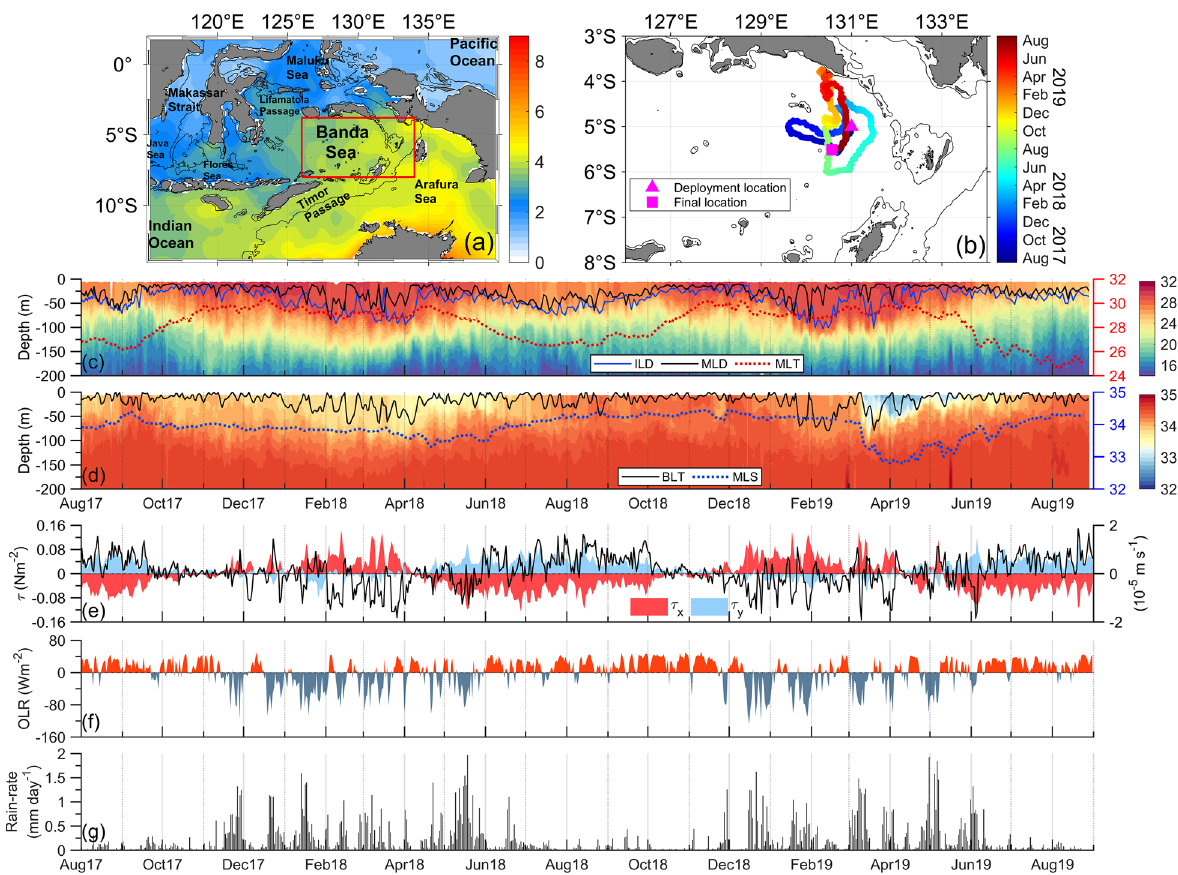
Fig. 1 a Map of the Indonesian Maritime Continent showing the amplitude of the seasonal cycle of SST (°C). b The trajectory of the Argo float (WMO ID 6901746) from August 2017 to August 2019. Solid black contours in a , b show the 500 m isobath. Time-depth sections of c daily temperature (°C) and d daily salinity (psu) along the trajectory of the Argo float 6901746. e Temporal evolution of daily zonal and meridional wind stress (N m − 2 ). f Daily OLR anomaly (W m − 2 ), and g daily precipitation (mm day − 1 ). The area boxed by red lines indicates the location of the area captured in b . The blue and black lines in c denote the ILD and MLD, respectively. The black line in d denotes the BLT. The dotted red and blue lines in c and d indicate the MLT ( o C) and MLS (psu), respectively. The black line in e denotes the vertical velocities (m s − 1 ) associated with Ekman pumping. All plots in Figs. 2 and 3 are based on a monthly average from the original daily